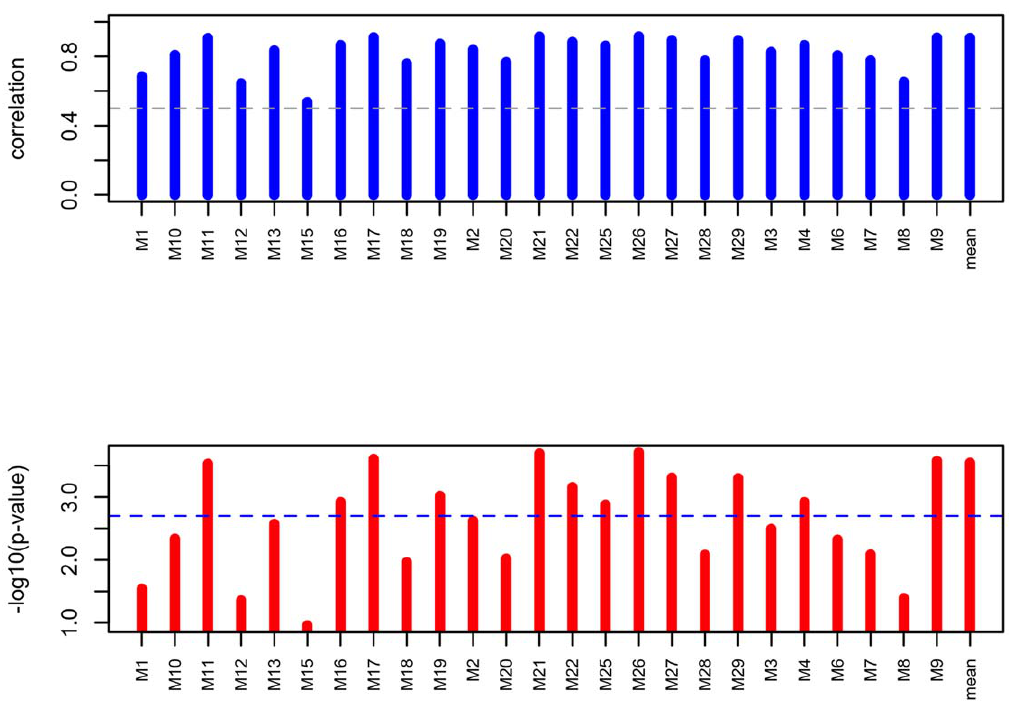
Figure 3. Corrected FFPE/Frozen correlations for each individual. The correlation test tries the hypothesis «the correlation is useless’’. The threshold represents the threshold reject alpha=5% (correct for the multiple test by Bonferroni). The individuals to spread are the ones who are below the threshold.